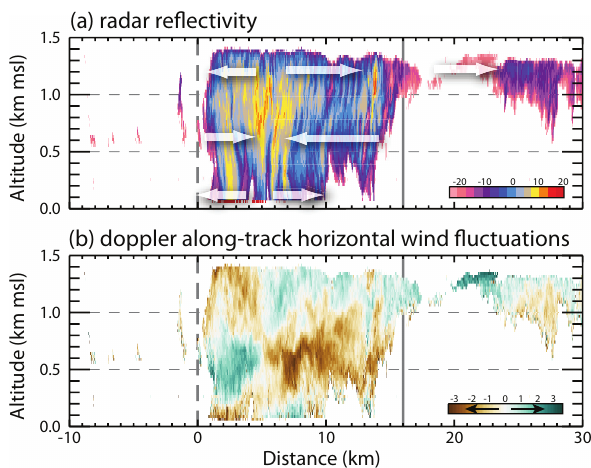
Fig. 23. (a) Radar reflectivity and (b) along-track horizontal wind component fluctuations derived from the WCR downward and slant-downward doppler (with the flight-averaged mean wind subtracted) for the AC leg during RF06.